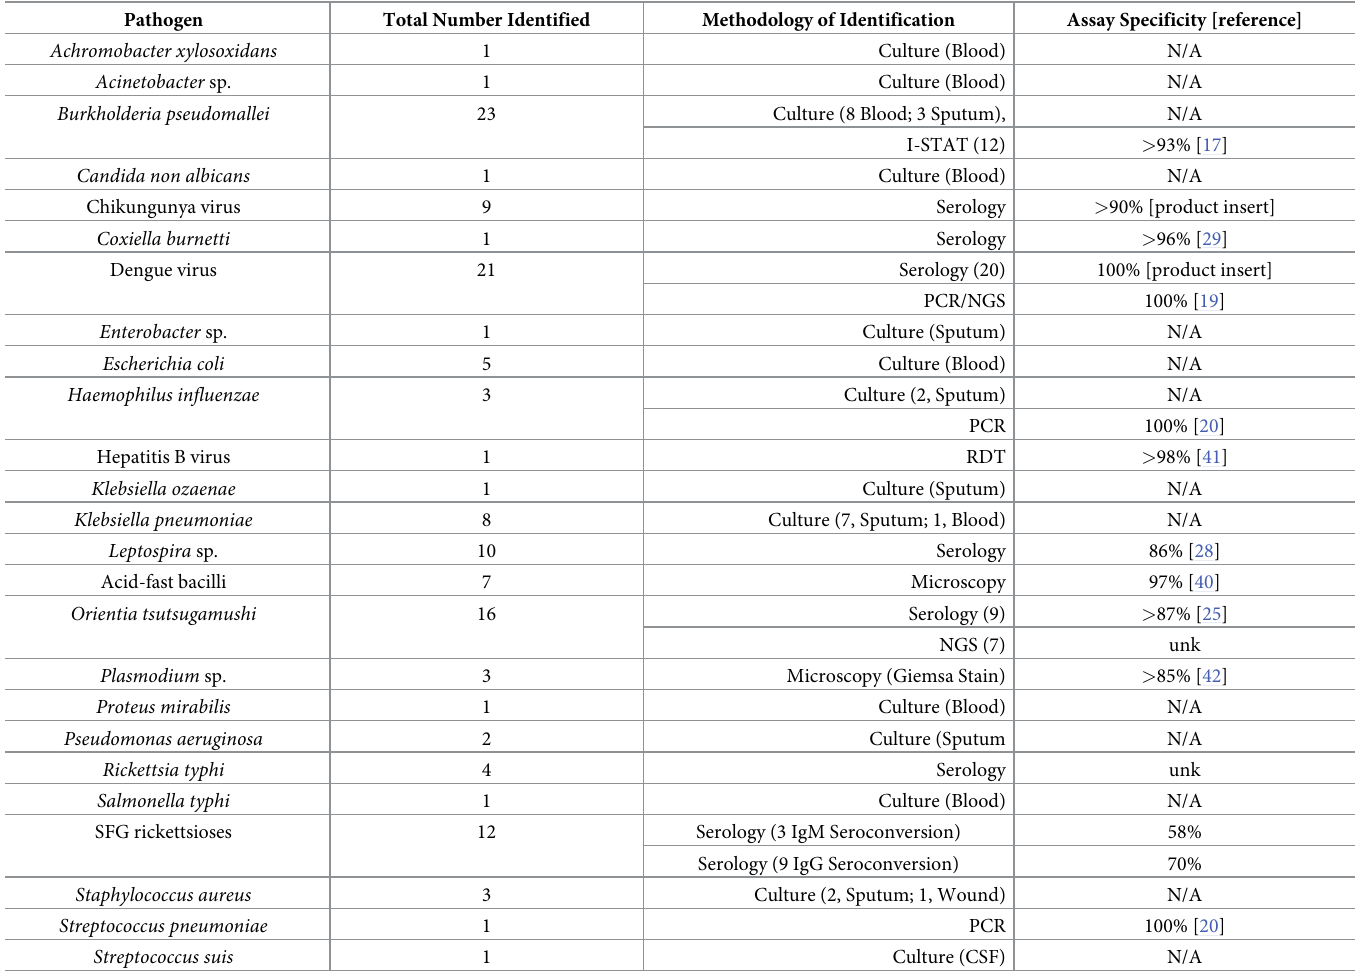
Table 3. Pathogens identified and method of